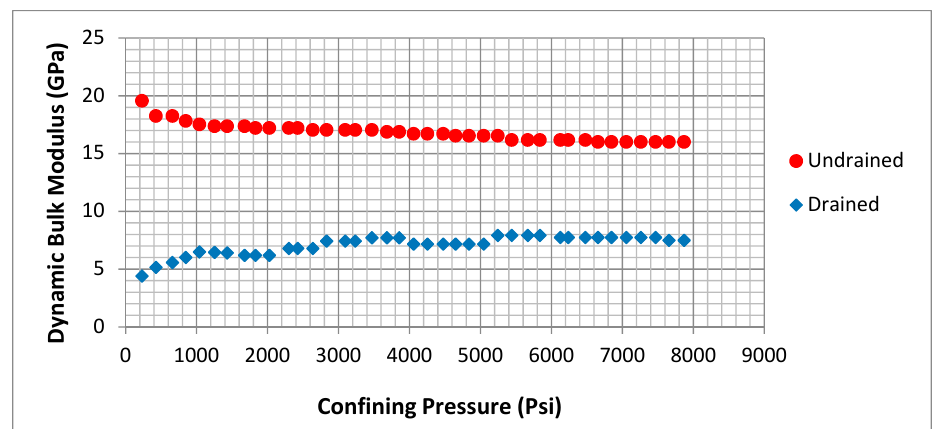
Figure 12. Undrained and drained dynamic bulk moduli vs. confining pressure for C6.